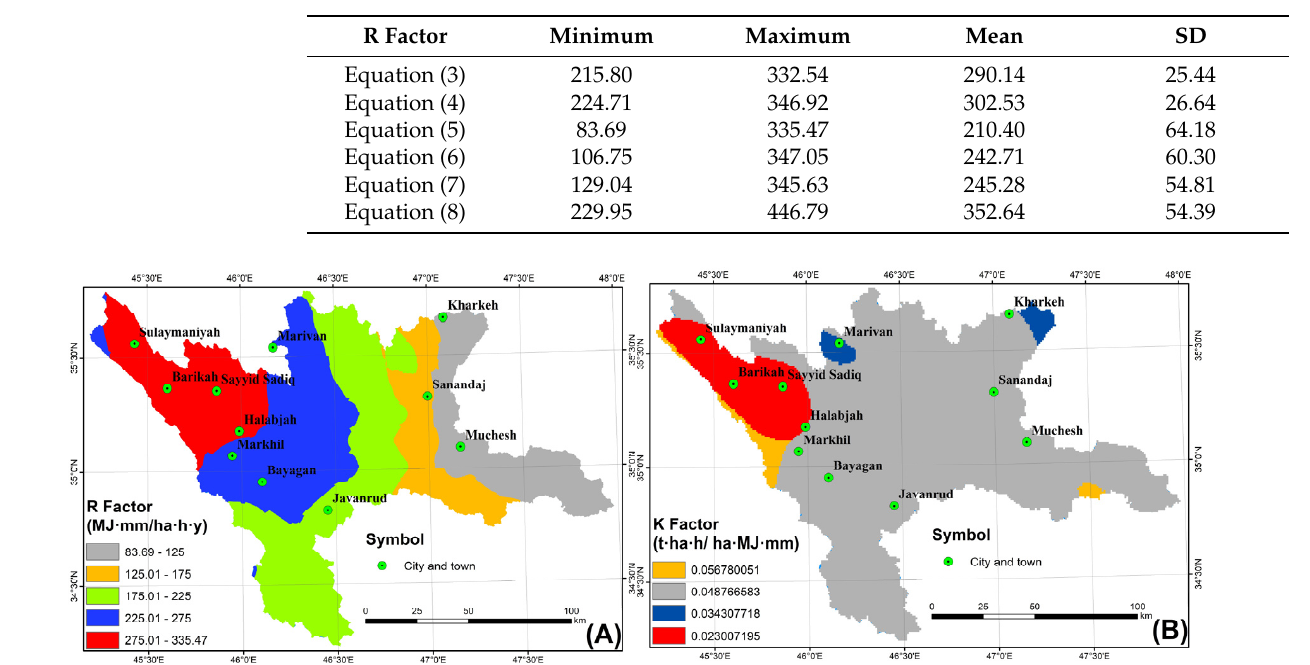
Table 8. R-factor parameters of the used models.